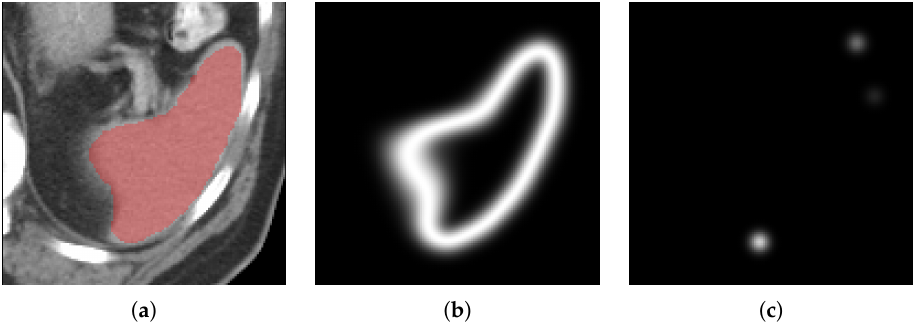
Figure 4. Visualization of the boundary enhancement map computed in Equations (6)–(8) in the paper. In this example, we show ( a ) the ground truth overlaid on the image, ( b ) the boundary enhancement map b ( P ) , and ( c ) the point channel G ( { e } ) on the corresponding axial slice of the 3D volume used in the computation of the point loss L points (see Equation (6)). The loss is minimized if the prediction’s boundary b ( P ) aligns with the center of each clicked extreme point e in G ( { e } ) . Note that during training, we compute the boundary on the model’s prediction P but here we show it computed on the ground truth for illustration